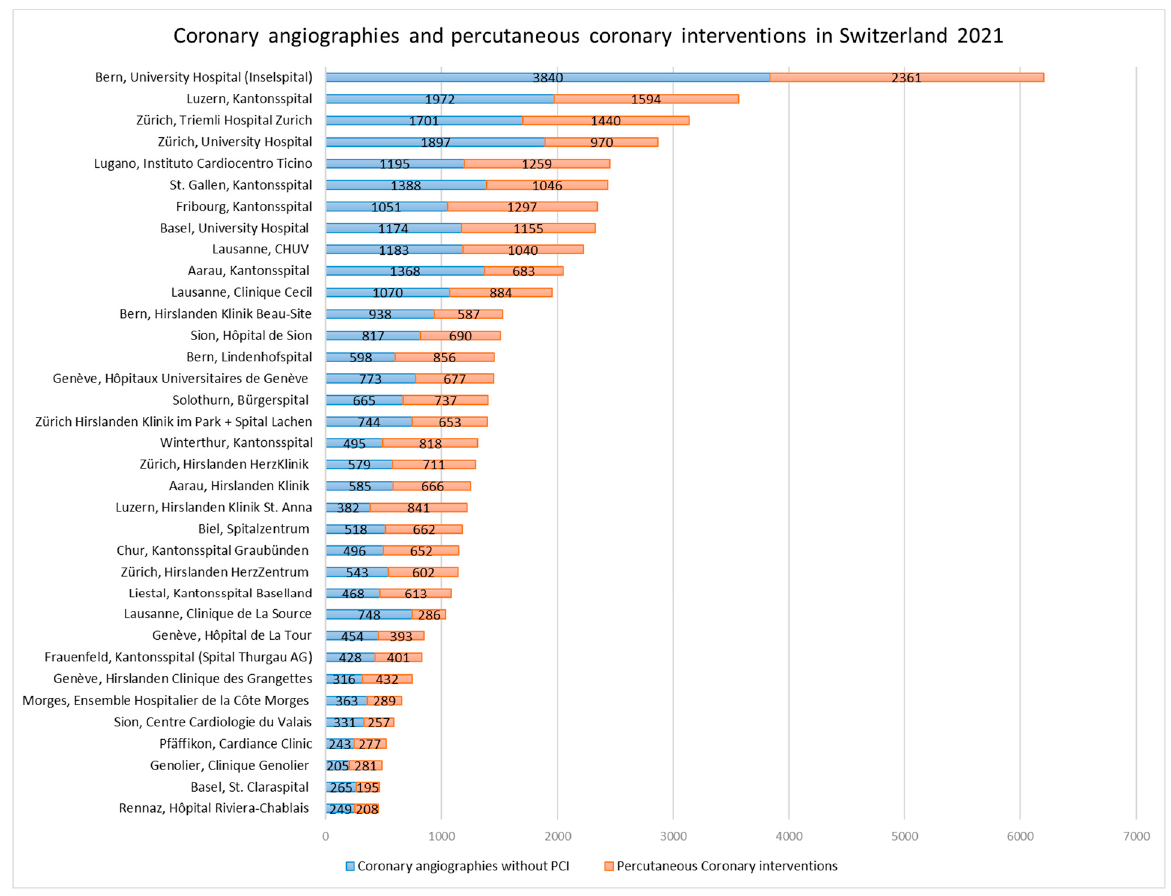
Figure 3. Coronary angiographies and percutaneous coronary interventions in Switzerland 2021, ranked by procedural numbers.